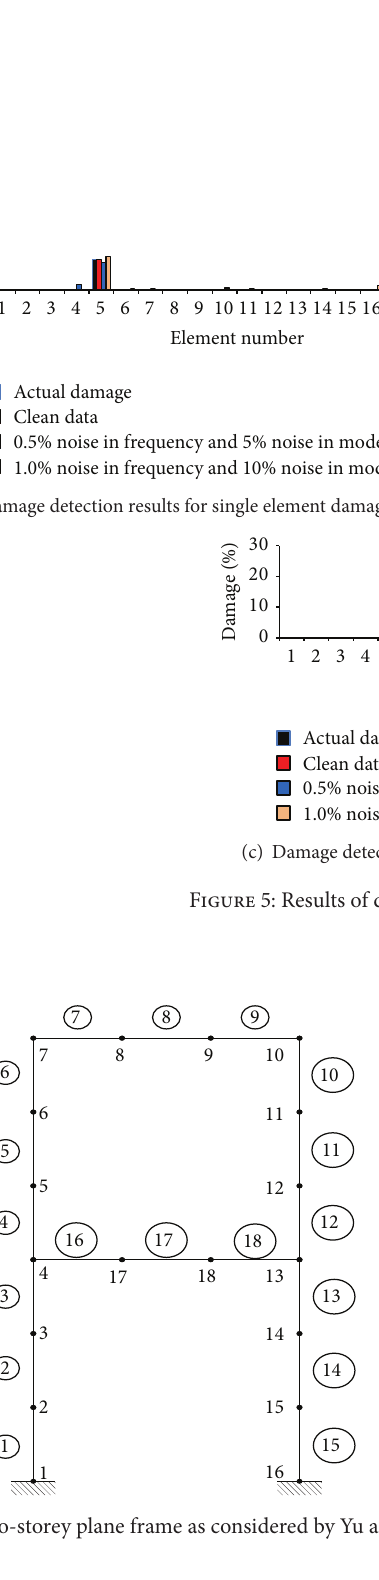
time with 2000 iterations in order to get an improved result.